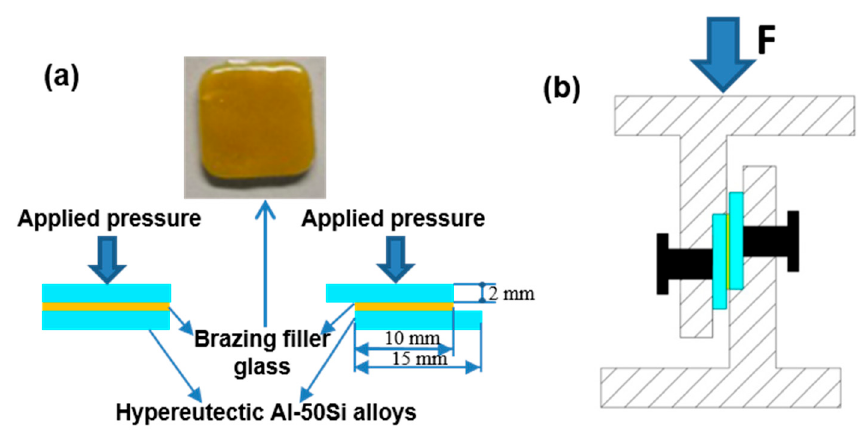
Figure 3. Schematic diagrams of experimental procedure: ( a ) brazing assembly method; ( b ) shear test device.